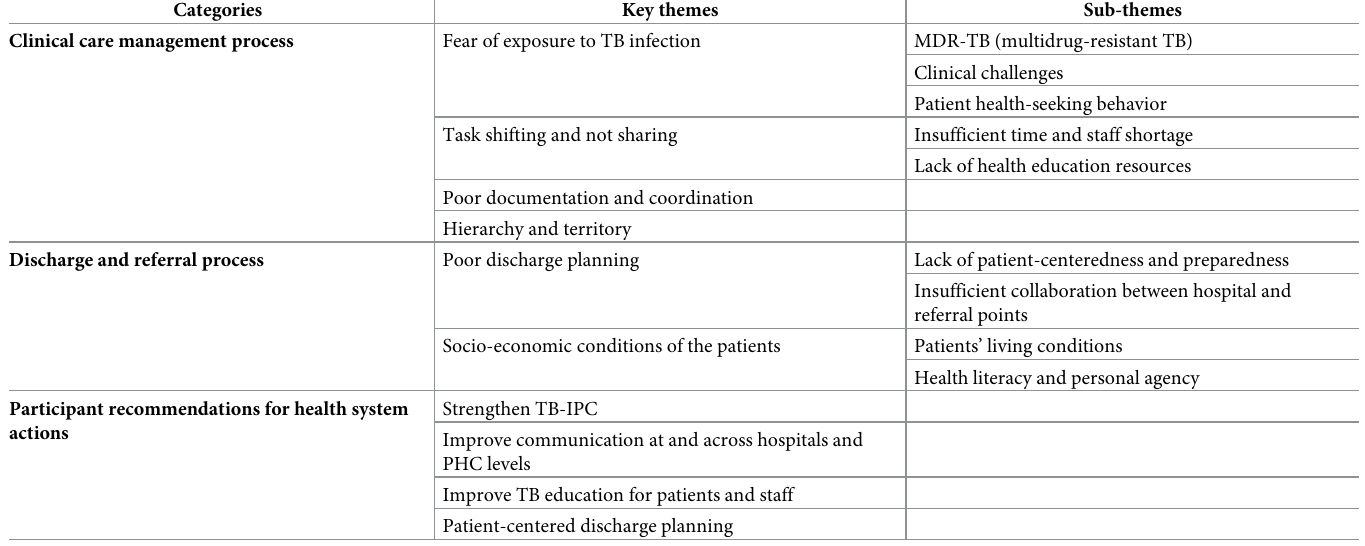
Table 2. Categories, key themes and sub-themes from participant